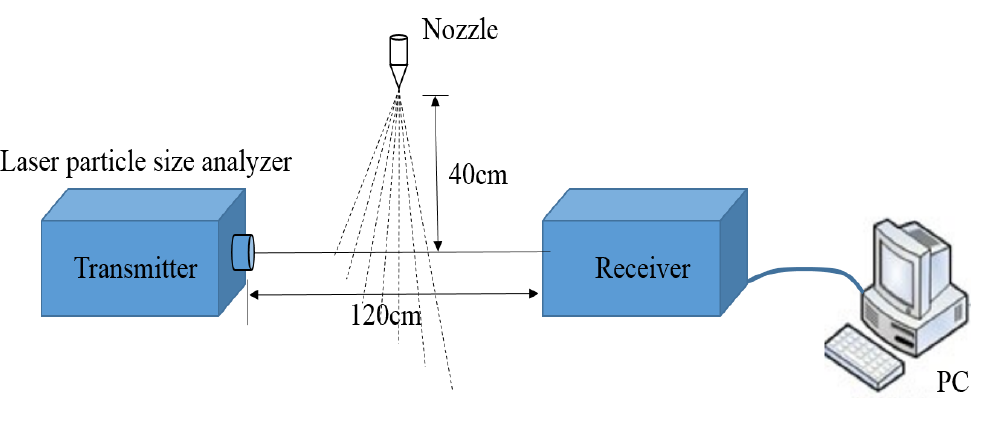
Figure 4. Droplet size measurement. Table 2. Results of droplet size measurement and test treatment.